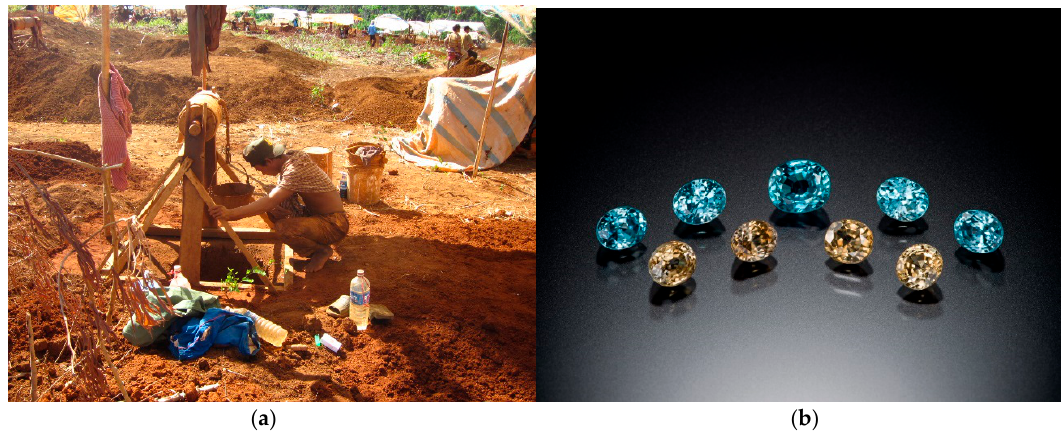
Figure 5. ( a ) Zircon miner at Phum Throm, Ratanakiri, Cambodia. ( b ) Natural and heat-treated faceted RVP zircon (each stone is ~0.75 carats). Photo copyright M. Bainbridge, Canadian Museum of Nature